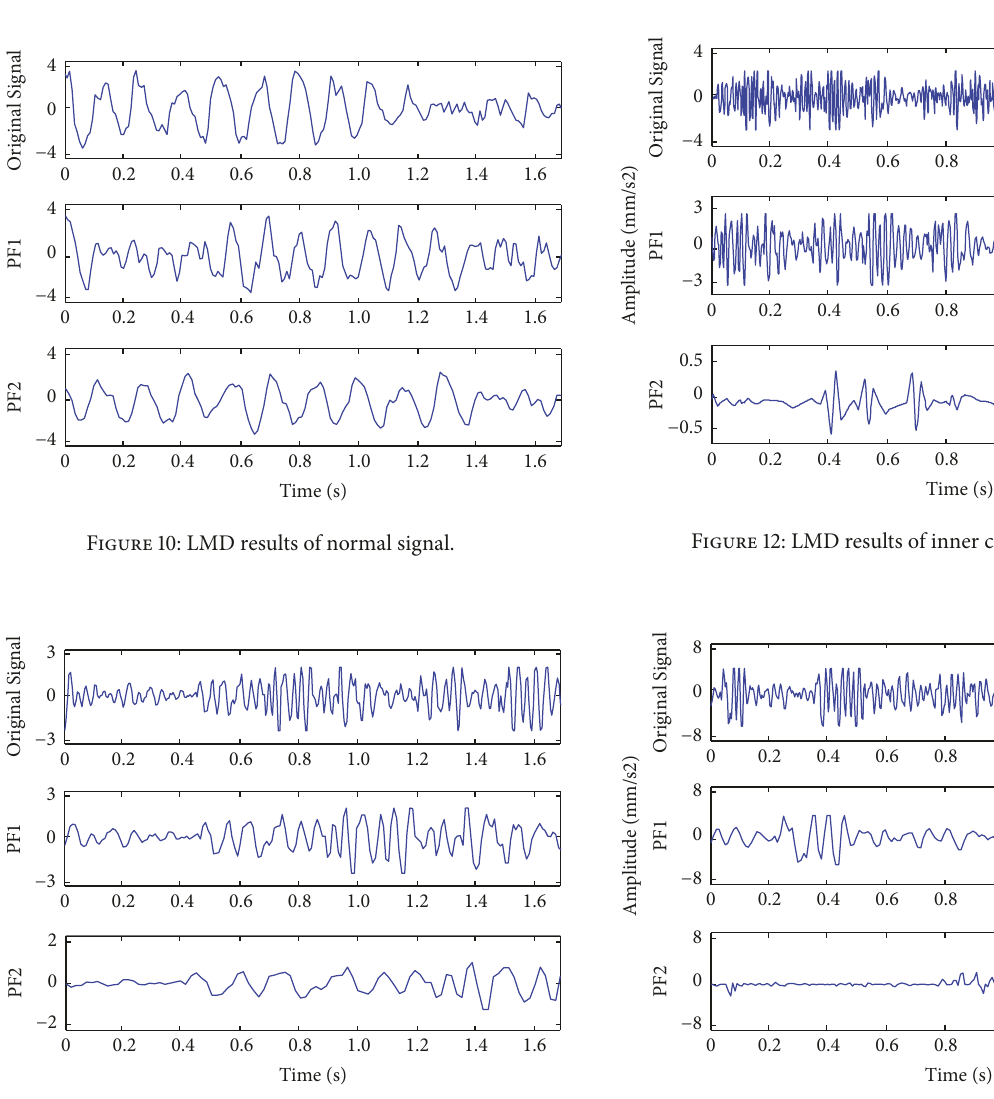
Figure 13: LMD results of outer circle fault